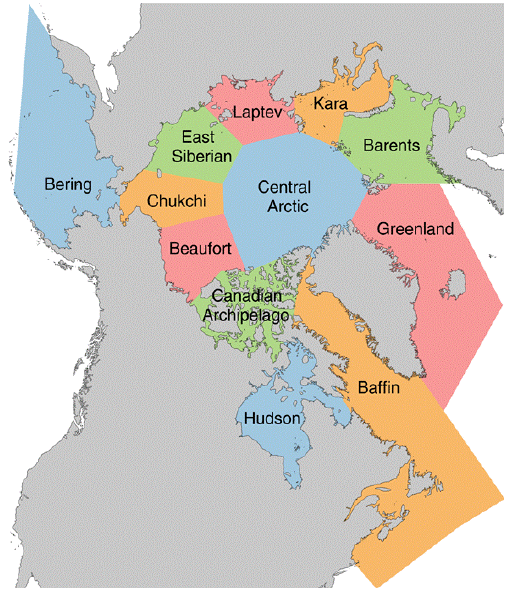
Figure 1. The MASIE subregions used in the study (NIC and NSIDC, 2010).